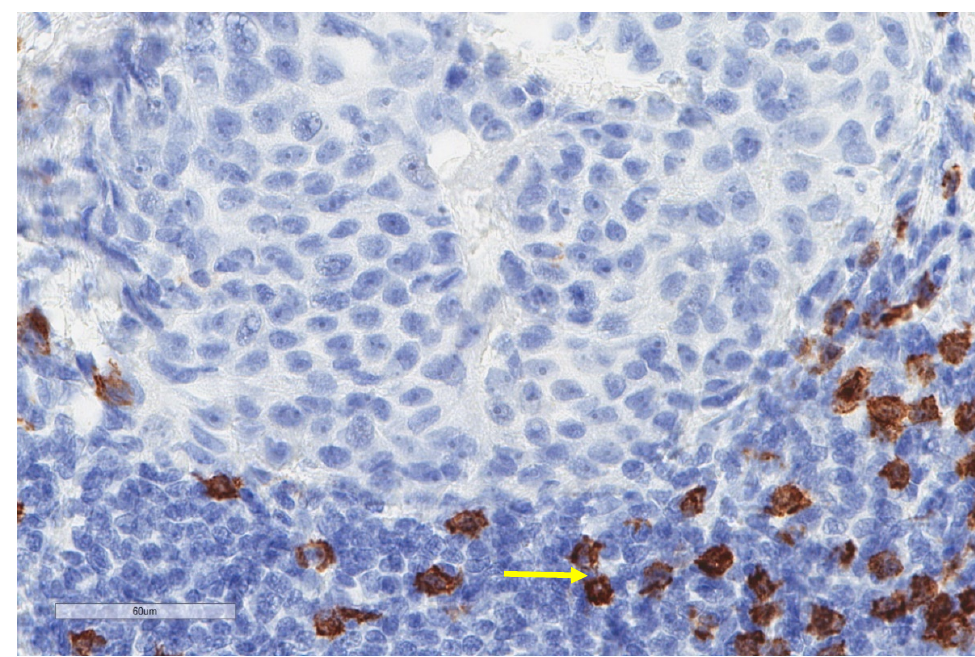
Figure 6. In comparison to the previous case, this malignant mesothelioma harbors few CD8+ lymphocytes (arrow), mostly in the peritumoral compartment (X400).